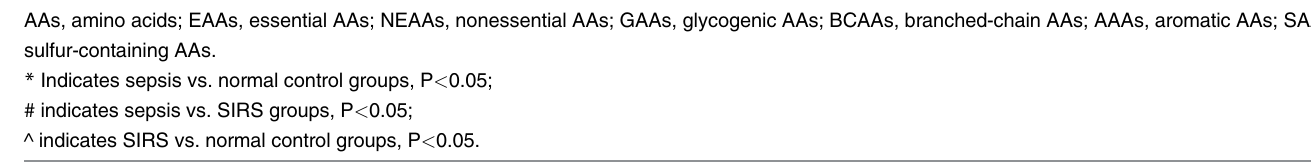
and SAA levels were -0.157 ( P = 0 . 04 ), -0.265 ( P < 0 . 001 ), and -0.325 ( P < 0 . 001 ), respectively (Fig. 4A). The correlation coefficients between the SOFA scores and cystine, taurine, and SAA levels were -0.244 ( P = 0 . 001 ), -0.319 ( P < 0 . 001 ), and -0.285 ( P < 0 . 001 ), respectively (Fig. 4B).